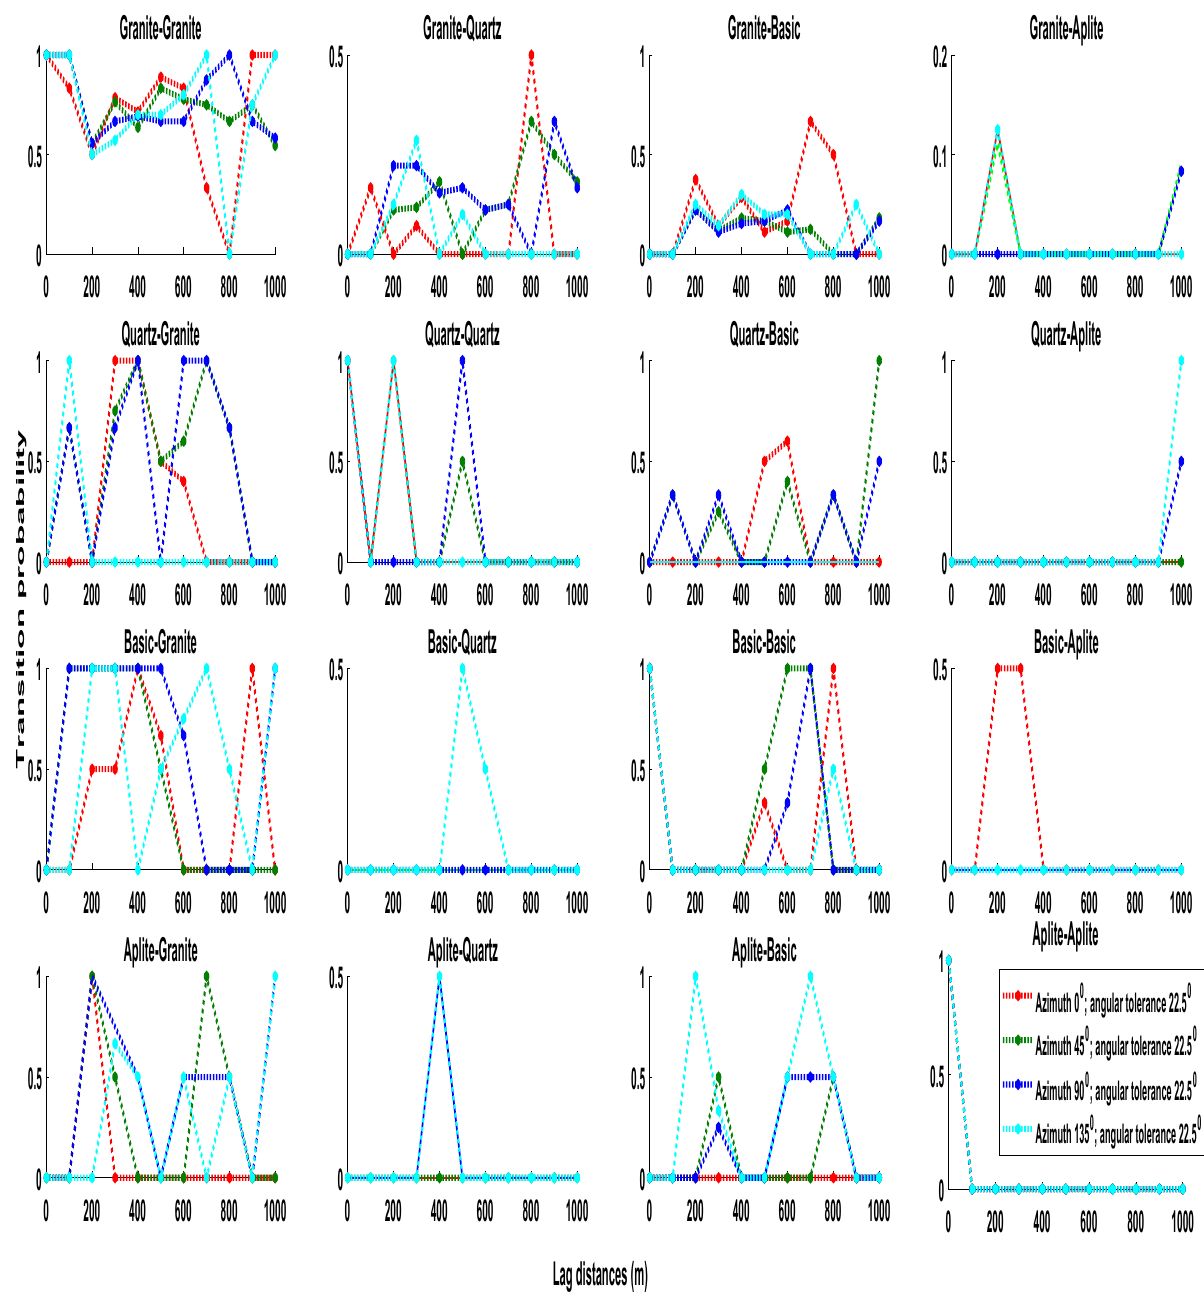
Figure 5. Four directional auto/cross-transiograms at different lag